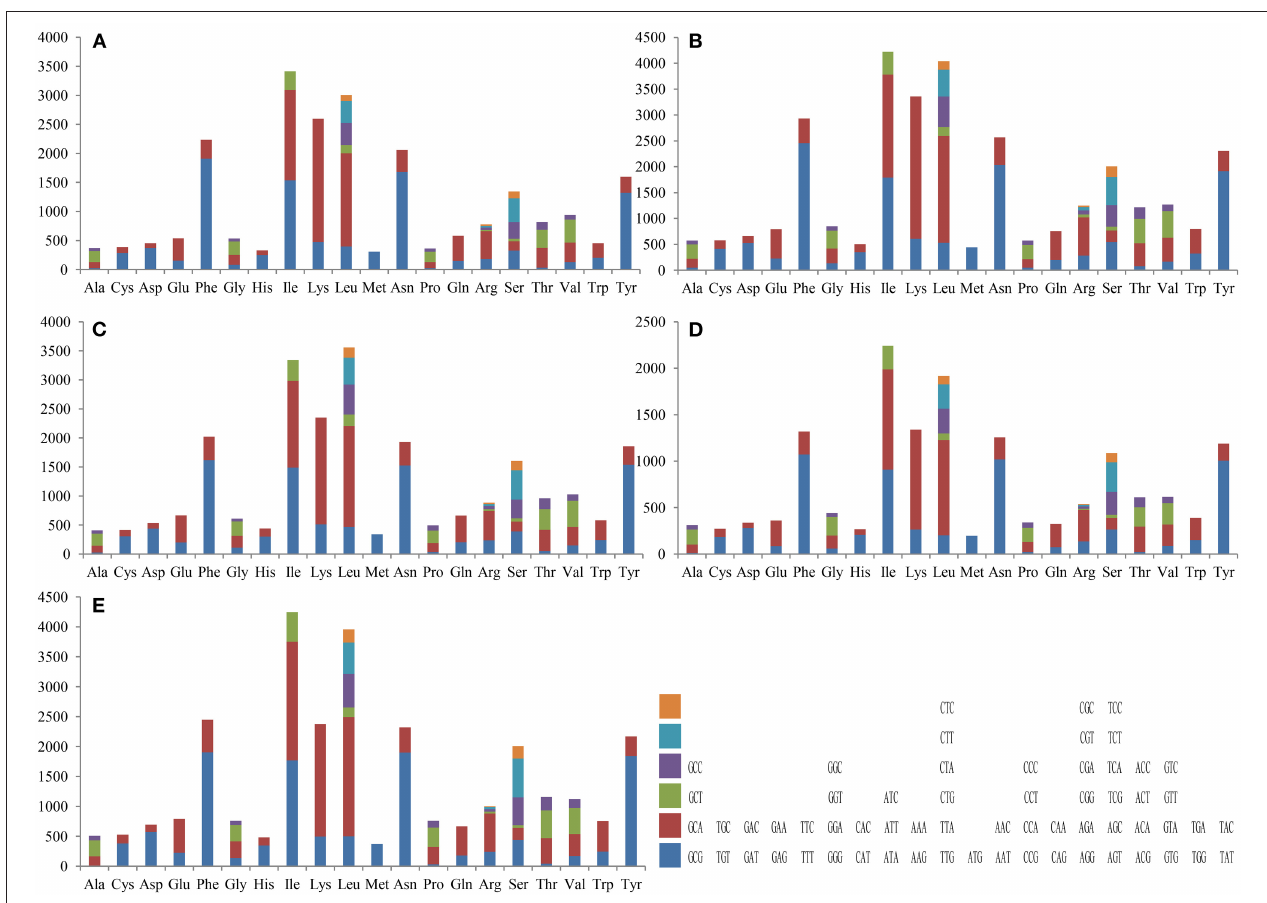
FIGURE 3 | Codon usage in the mitochondrial genomes of five Tricholoma species. Frequency of codon usage is plotted on the y-axis: (A) T. matsutake SCYJ1; (B) T. bakamatsutake ; (C) T. terreum ; (D) T. flavovirens ; and (E) T. saponaceum